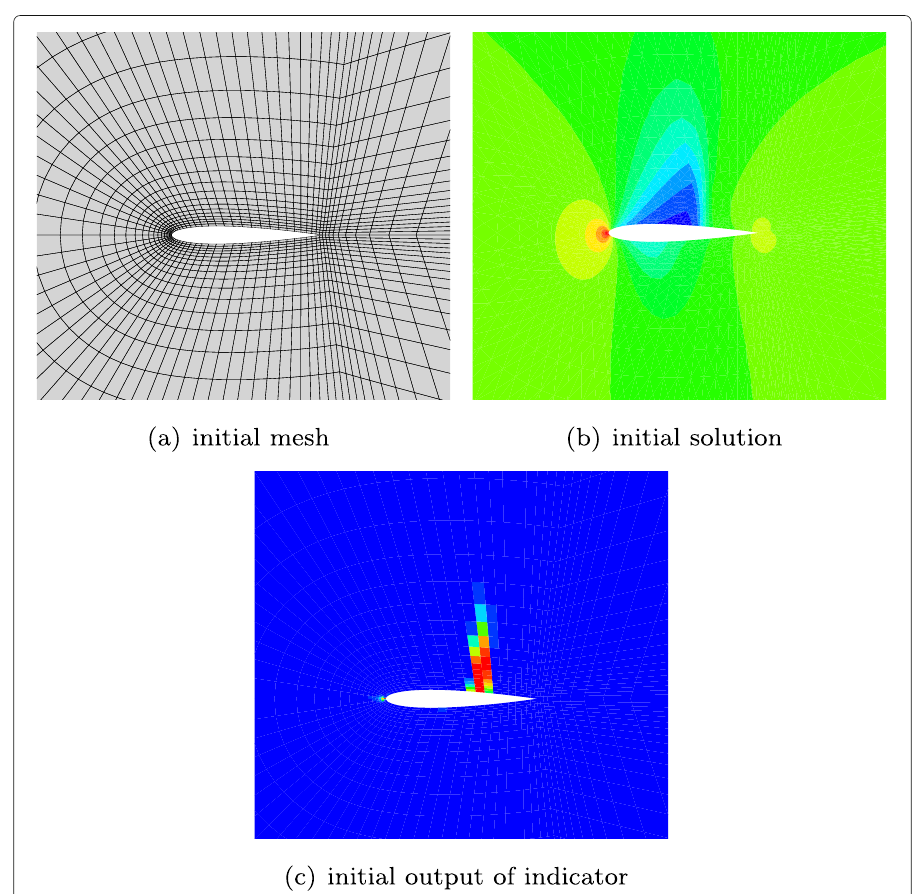
Fig. 18 Initial mesh and solution (density) of the transonic flow around the NACA0012 airfoil under DG(p2)